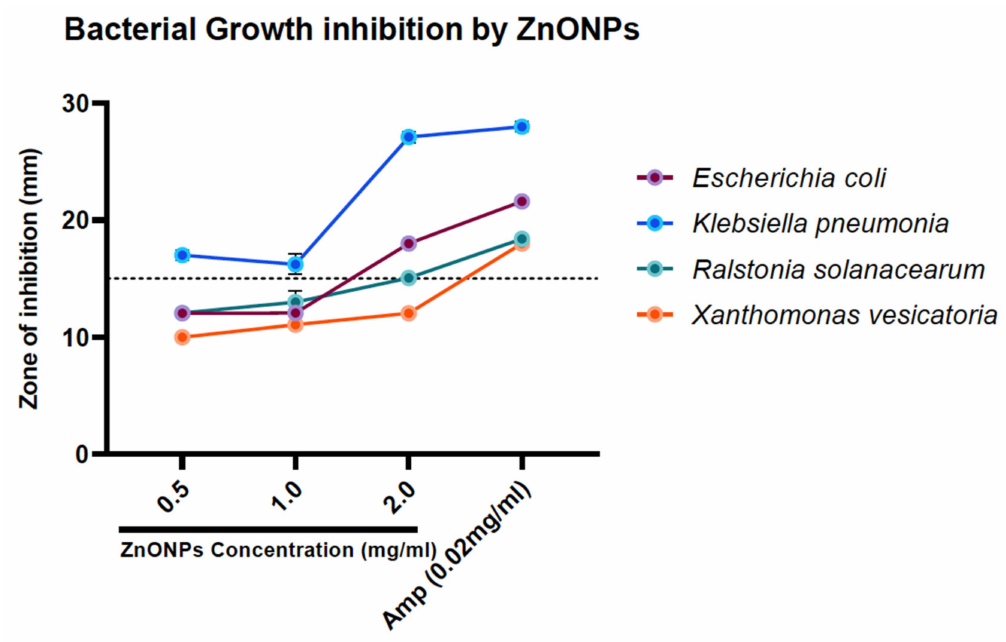
Figure 8. Zone of inhibition graph by ZnONPs against selected bacterial strains.